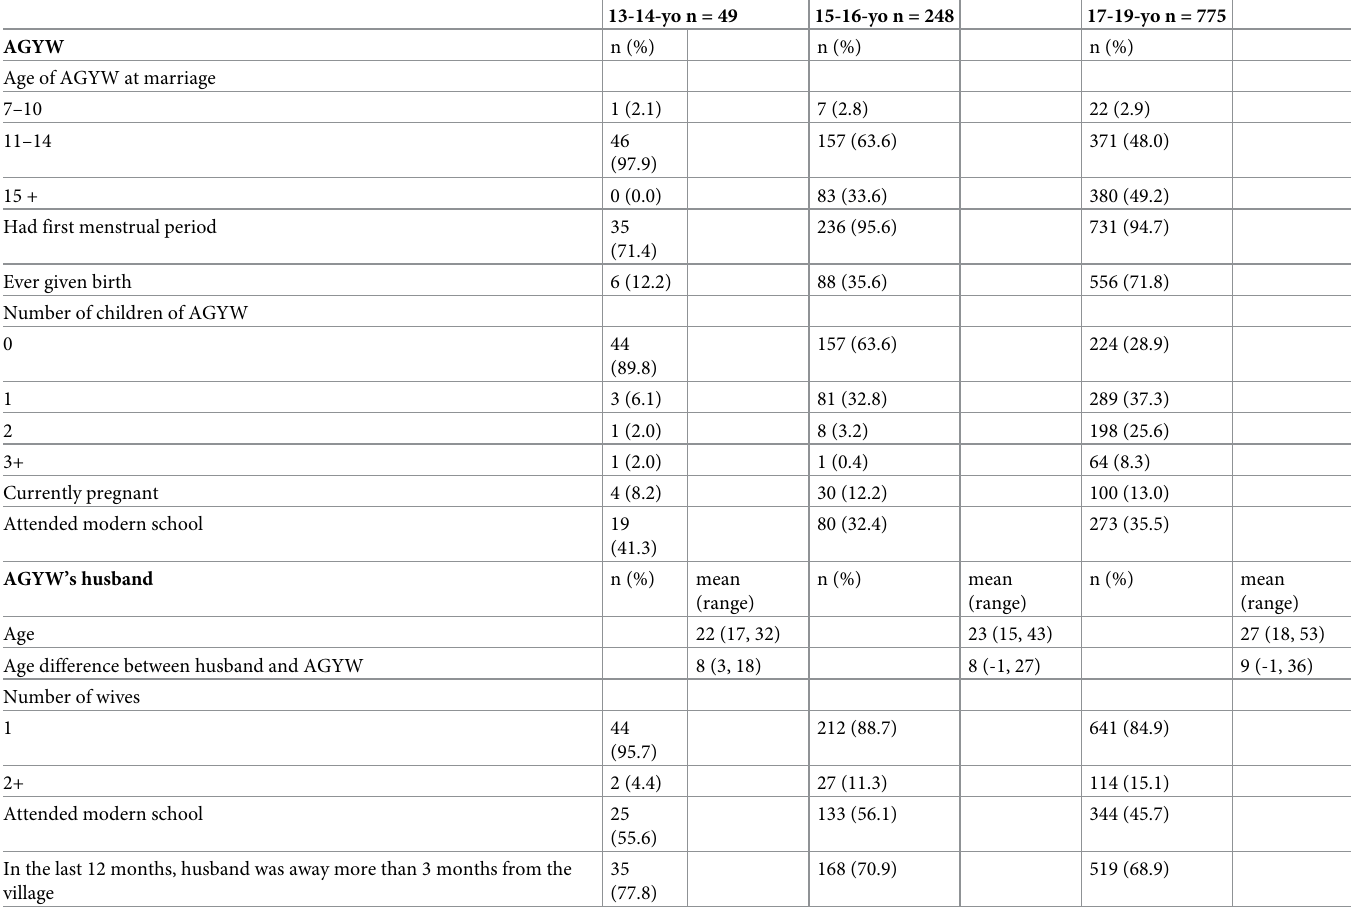
Table 1. Baseline characteristics of married AGYWs and their husbands in Dosso region, Niger, by age group (n =